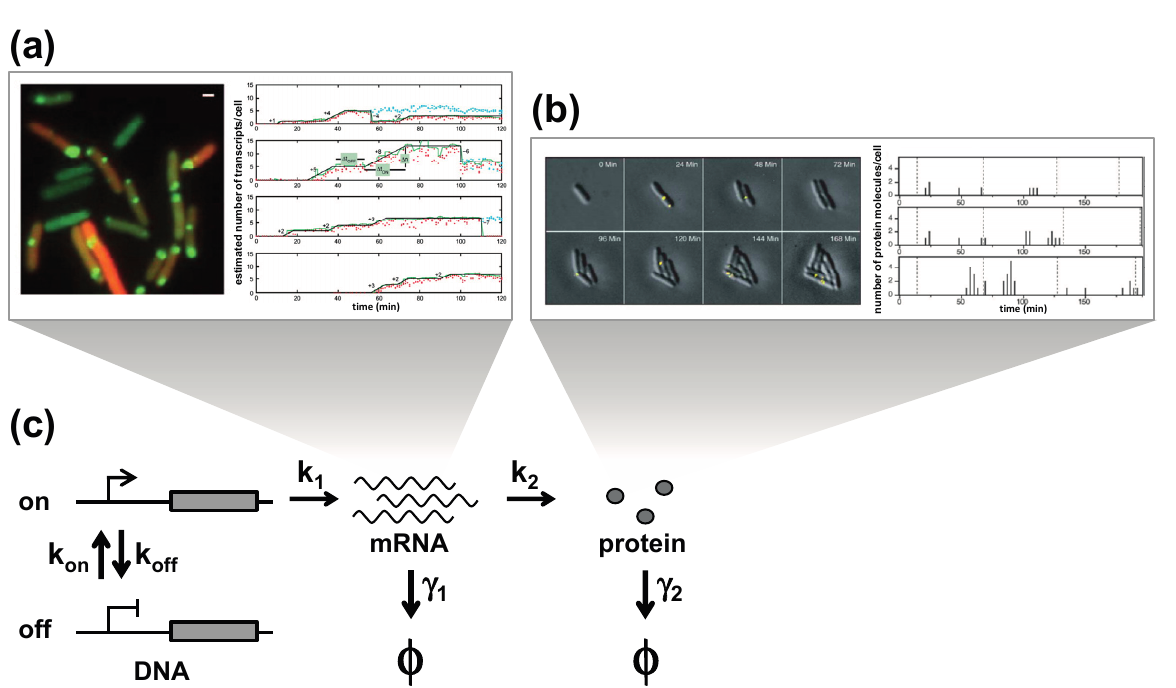
and k . During the on off , and proteins are translated at the rate k . 1 2 and γ , respectively. The states of 1 2